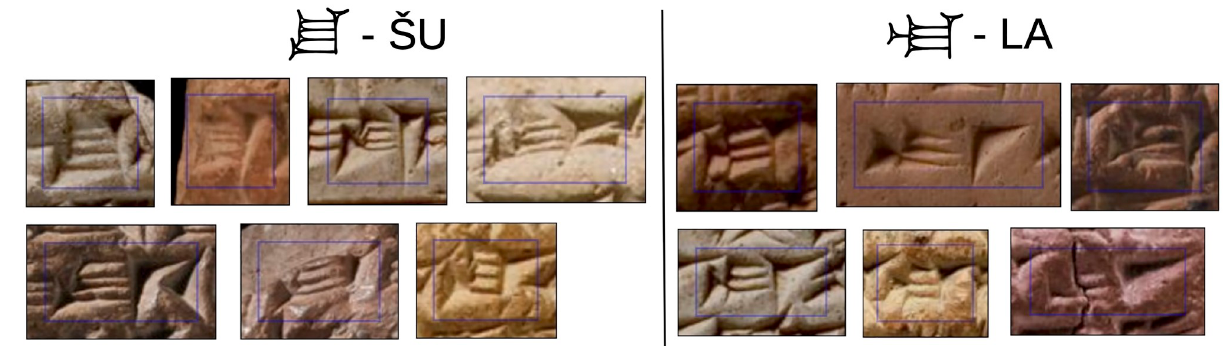
Fig 2. The problem of fine-grained sign similarity. Detecting individual signs on a cuneiform tablet usually requires the expertise of an Assyriologist. Cuneiform signs of different sign code classes may look very similar, while signs of the same sign code class may look very different. Image material by the